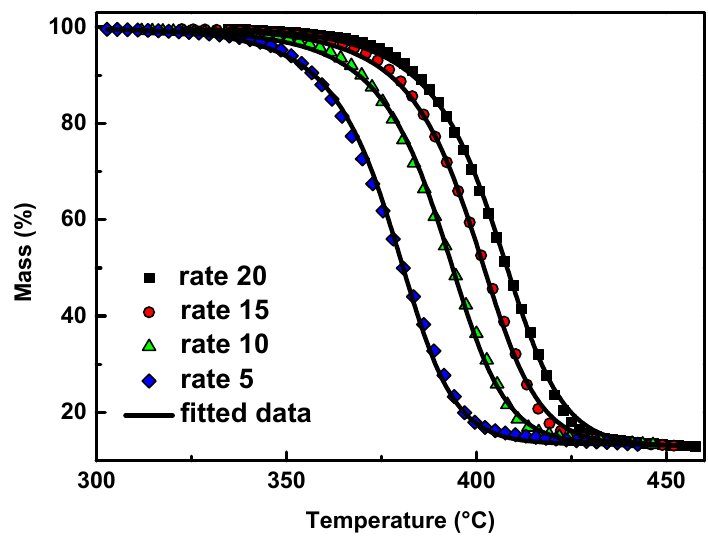
Figure 6. Mass (%) curves of neat PPF at heating rates of 5, 10, 15, and 20 °C/min in a nitrogen atmosphere (symbols) and the corresponding fitting curves with the Cn reaction model (continuous black lines).